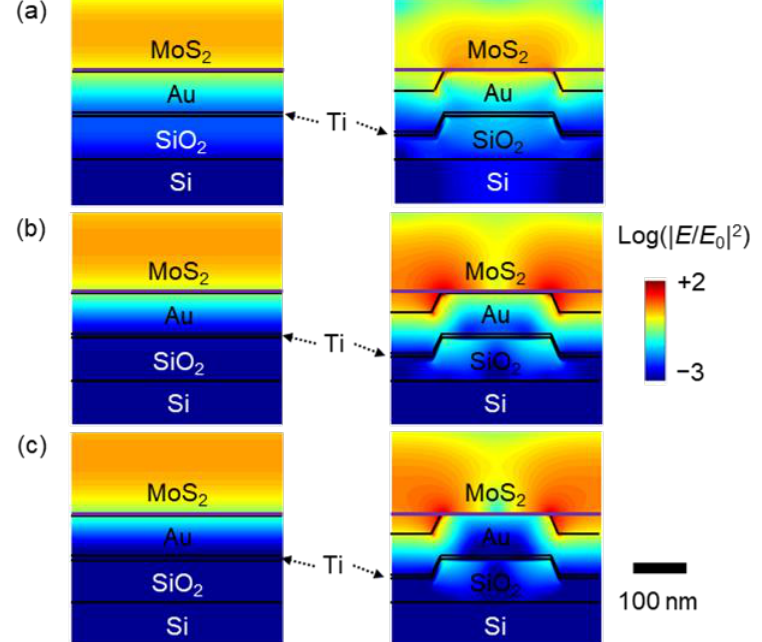
Figure 5. FDTD-calculated electric field ( E ) intensity distribution of MoS 2 /Au and MoS 2 /Au-NP at wavelengths of ( a ) 530 nm, ( b ) 615 nm and ( c ) 660 nm. E 0 indicates the magnitude of the electric field of the incident light.